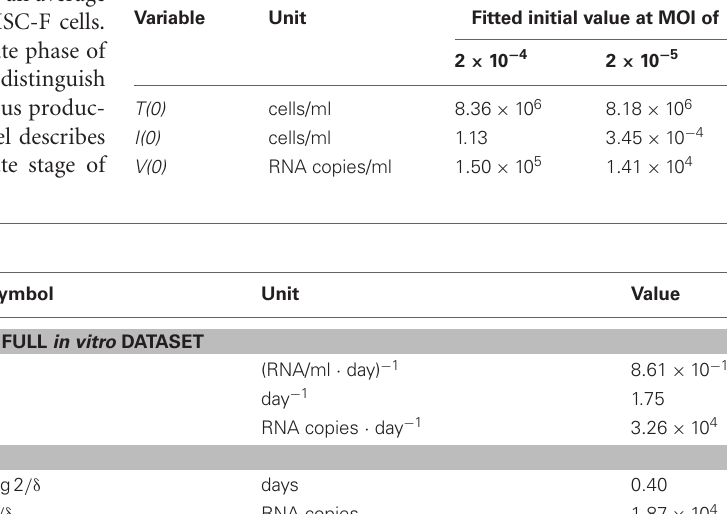
Table 3 | Fitted initial values for the in vitro experiment.